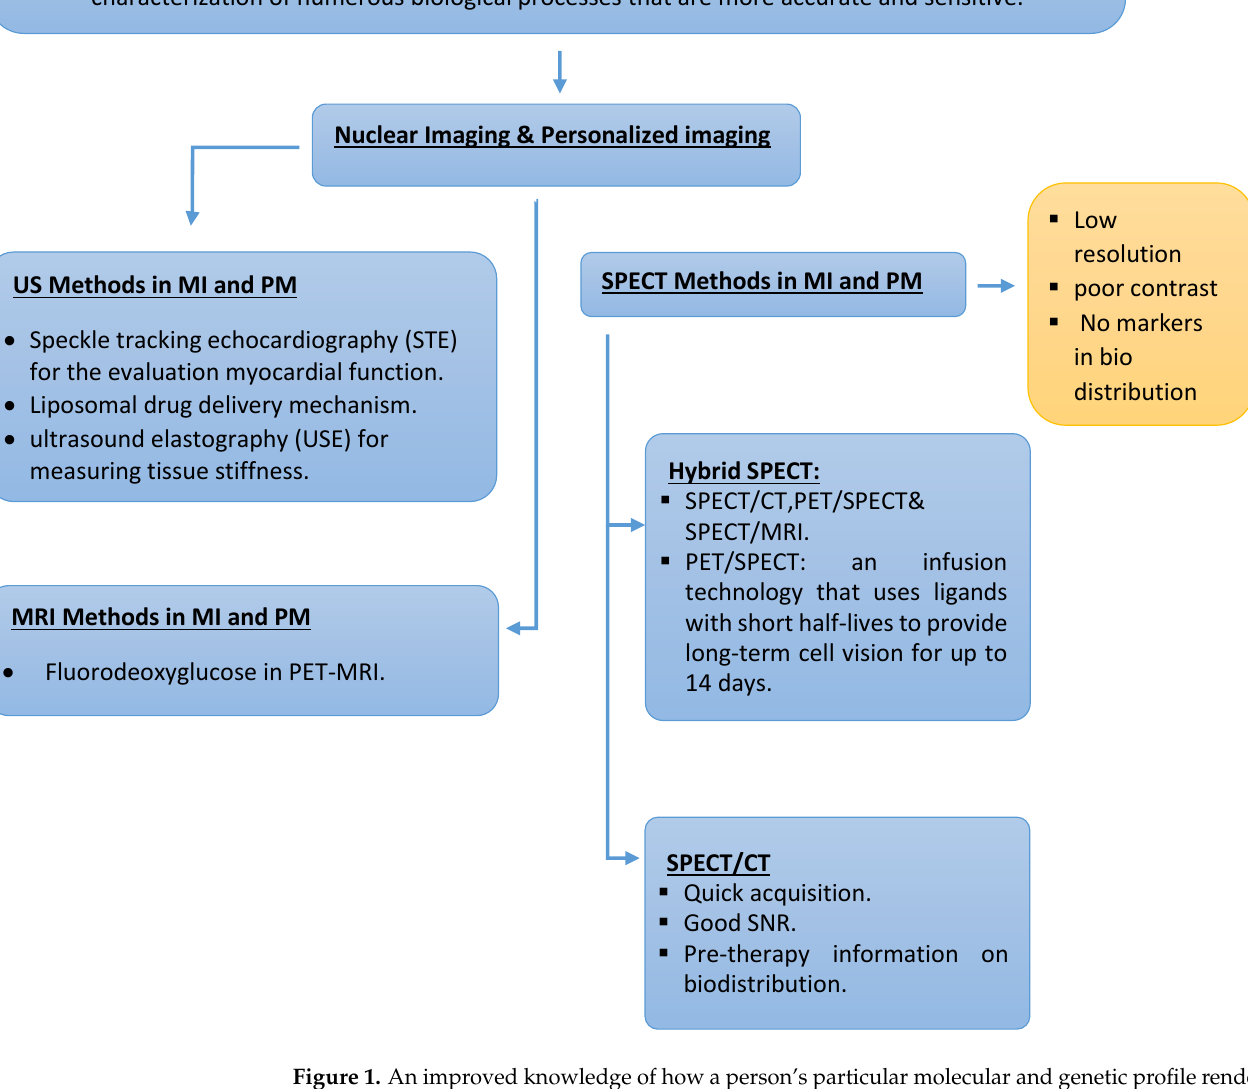
The ability of molecular imaging to identify very small cancers and statistically measure their activity.